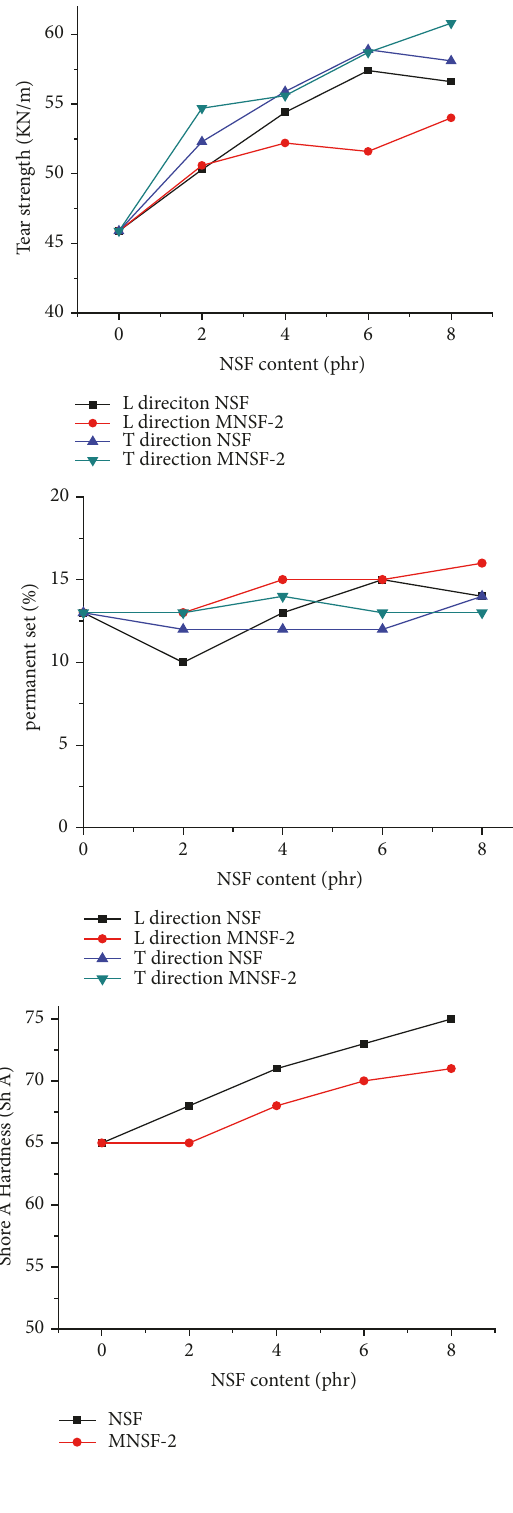
Figure 7: Effects of fibers content and the orientation on mechanical properties of